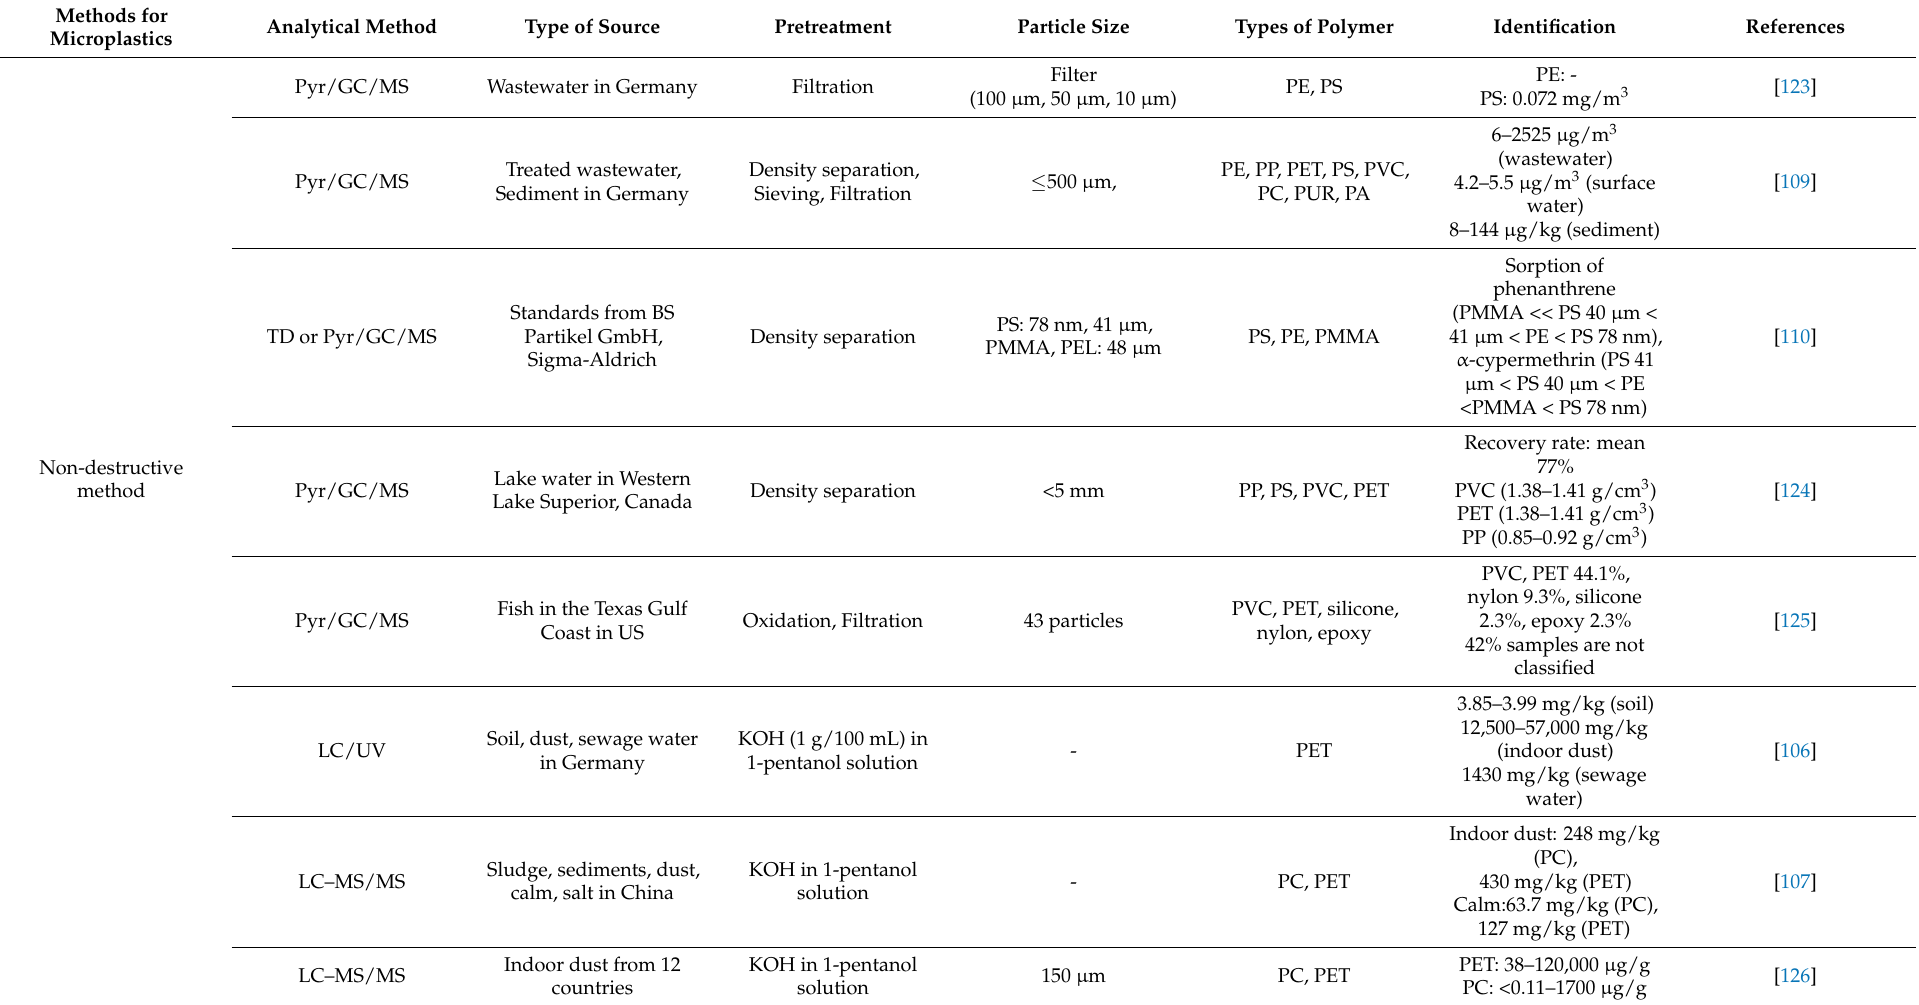
Table 4. Destructive analytical method for microplastic